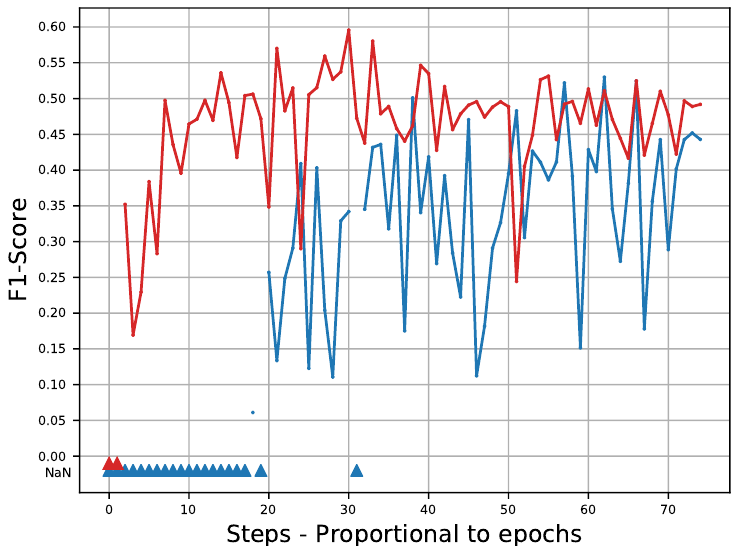
Figure 11. Evolution of F1 -Score during training for Class 3 calculated on validation set. Blue curve corresponds to a training set with no oversampling ( η ≈ 0.3) and red curve correspond to a training oversampled with η = 0.9. Triangles stand for undefined F1